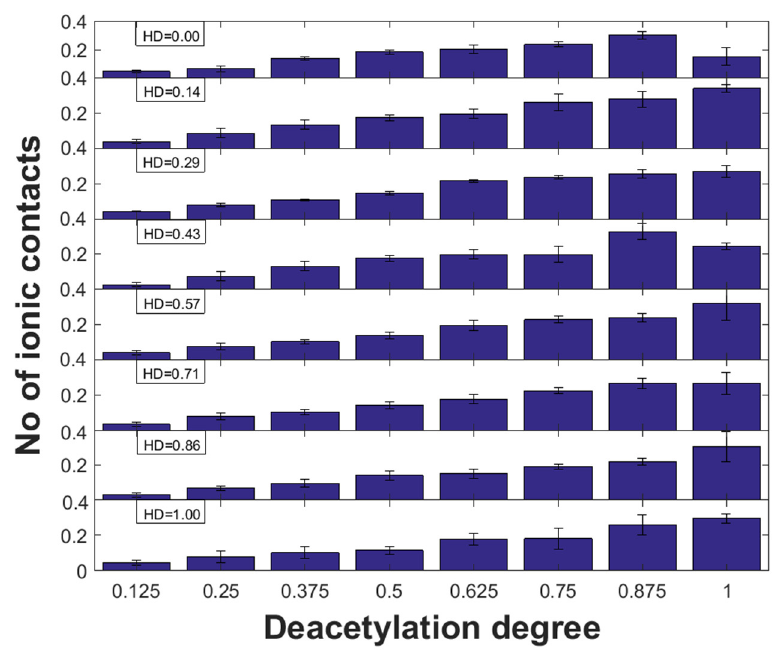
Figure 6. Number of ionic contacts vs. chitosan DD for different HD of collagen.